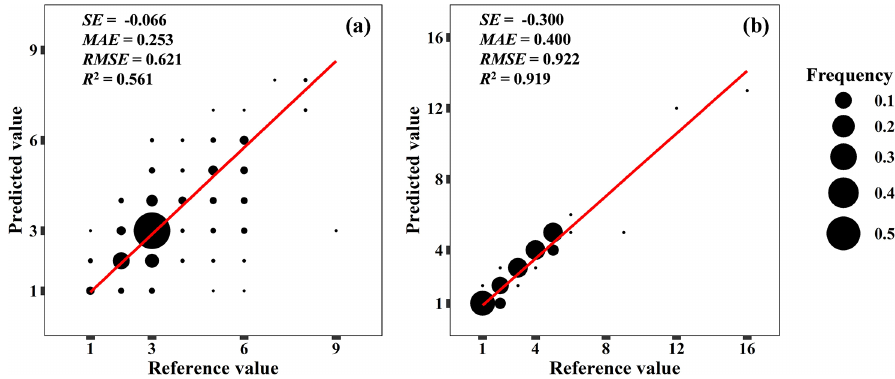
Figure 3. GCI30 accuracy assessment based on RDsat (a) and RDsite (b) . The red line represents the linear fitting line with the intercept forced to 0. The frequency of a specific reference–prediction value pair is proportional to its point size. Samples identified as continuous- cropping types were excluded.